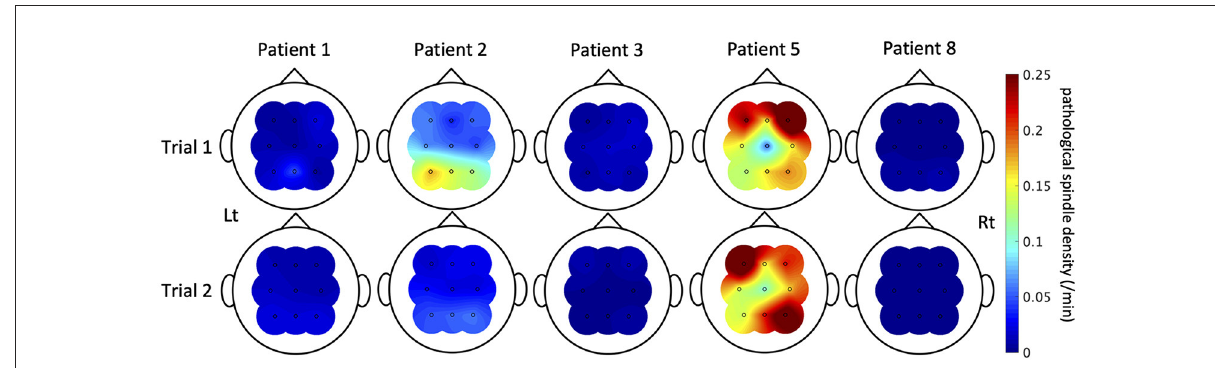
FIGURE5 The pathological spindle density distributions. The distributions of interictal epileptic discharge (IED)-coupled spindles are shown here of the five patients in whom IED-coupled spindles were present. The color bar indicates the density of IED-coupled spindles. The nature of fluctuation of IED-coupled spindles between Trials 1 and 2 varied among patients and